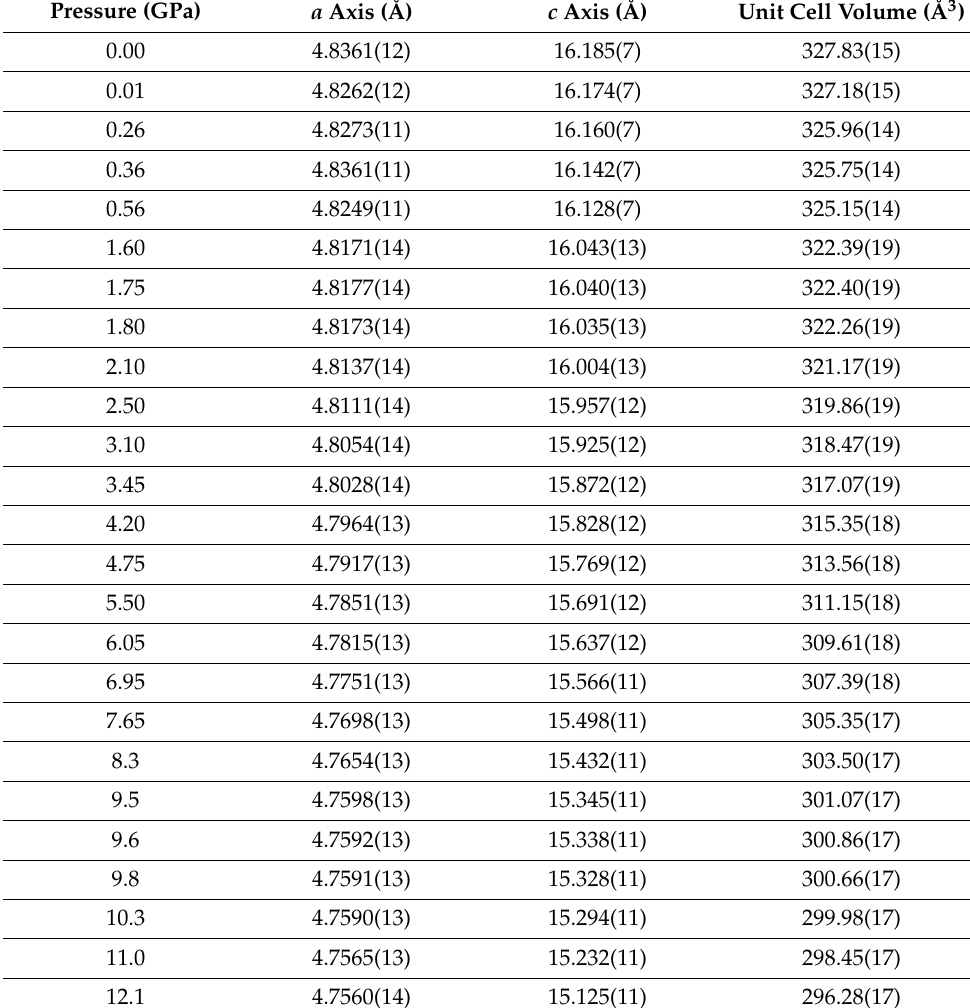
Table 1. Experimentally determined lattice parameters ( a and c ) and unit cell volume of R